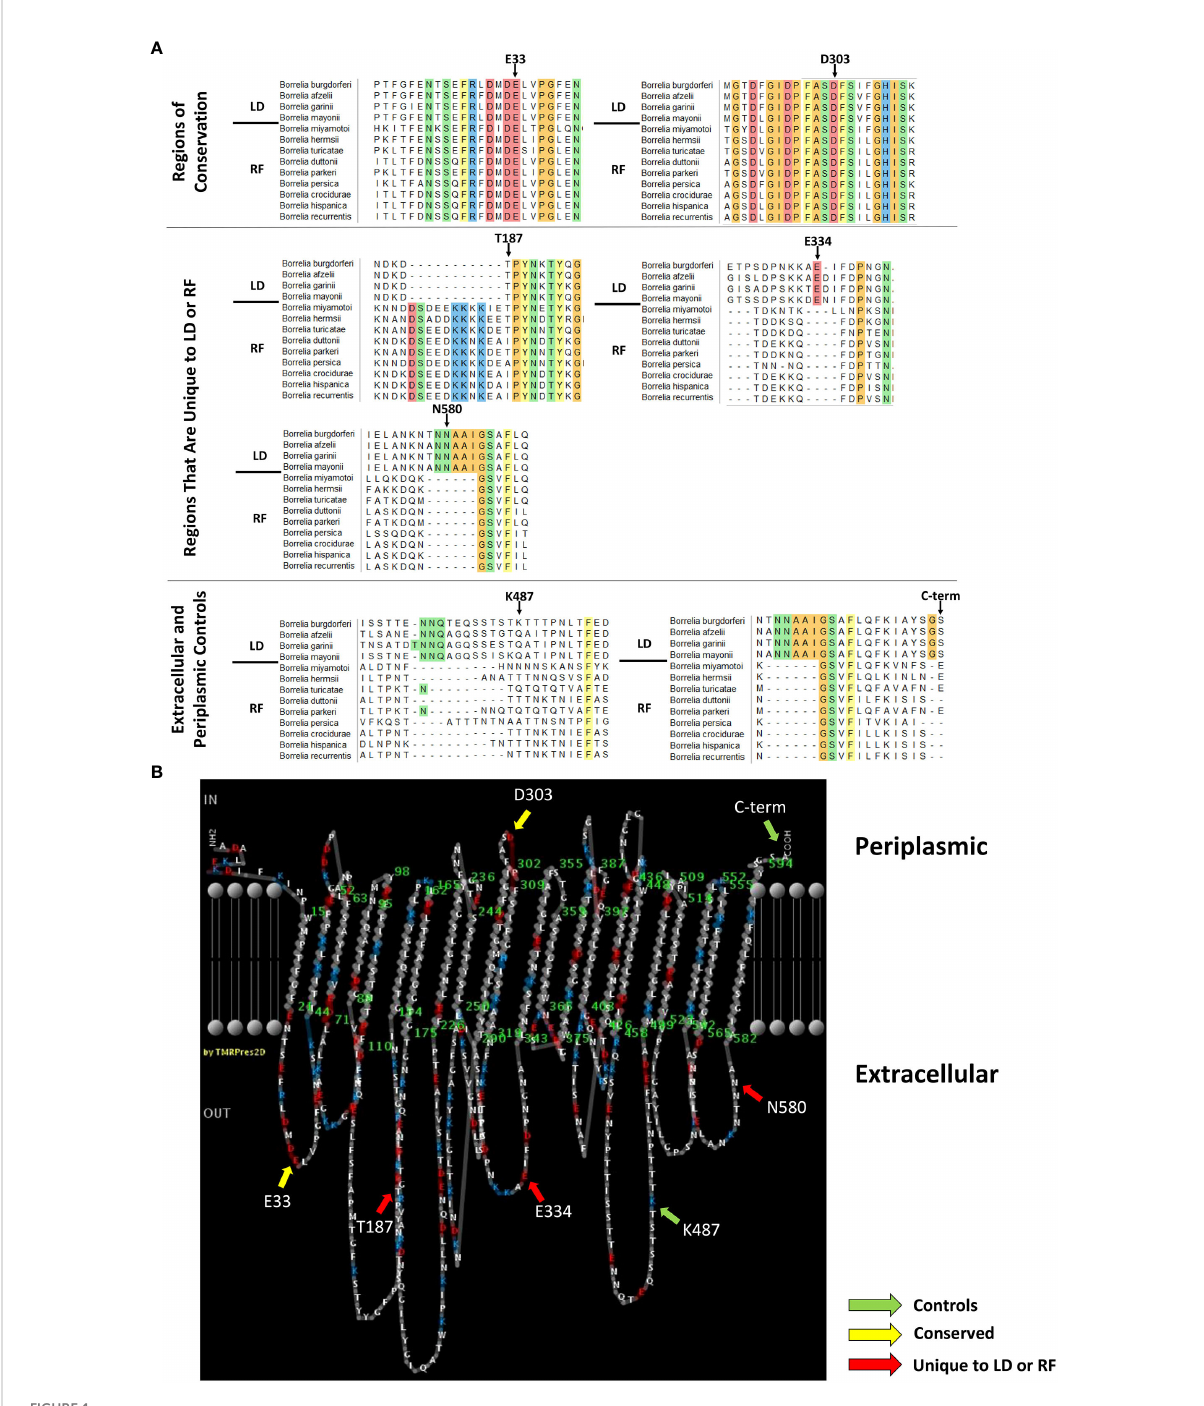
FIGURE 1 P66domainsselectedforc-Myctaginsertion. (A) P66sequencesfromLymedisease(LD)-andrelapsingfever(RF)-causing Borrelia specieswerealigned usingMultipleAlignmentFastFourierTransform.The fi rstfoursequences(abovetheblackline)areP66sequencesfromLD-causing Borrelia .Thelastnine sequences(belowtheblackline)areP66sequencesfromRF-causing Borrelia .Aminoacidsthatareconservedinallspecieslistedarehighlightedand coloredbysidechainchemistry:yellowforaromatic,redforacidic,blueforbasic,orangefornonpolar,andgreenforpolar.Arrowsindicatetheaminoacid forwhichtheregionisnamedandwhichisdirectlyN-terminaltothec-Mycinsertion. (B) PRED-TMBBprediction(PosteriorDecoding)ofthepredicted periplasmic,transmembrane,andextracellulardomainsofLD-causing B . burgdorferi P66withdomainsfrom (A)